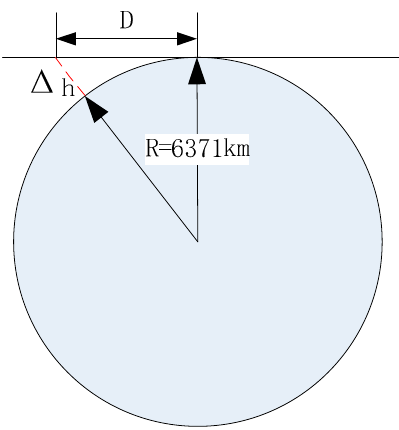
Figure 7. Influence of the Earth’s curvature on the height of a distant object. The greater the distance (D) of an object from an observation point, the greater the difference in height h, and thus the lower the observed height on the Earth’s surface.